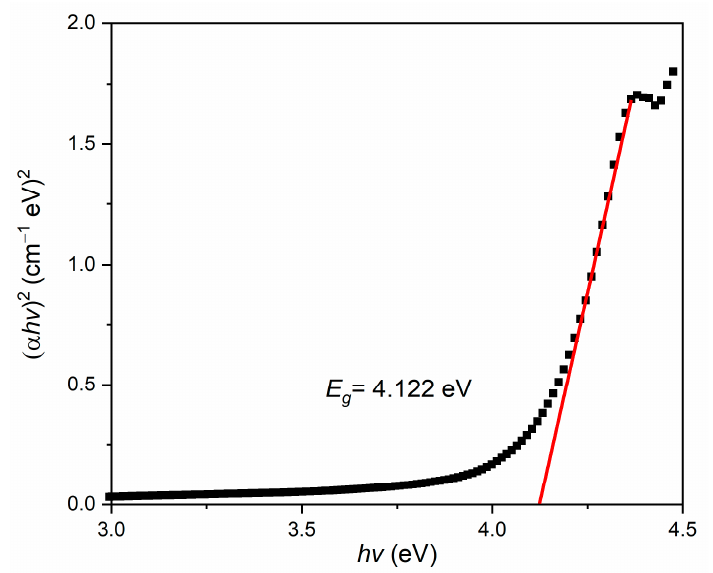
Figure 7. Energy band gap of the PEDOT thin film.